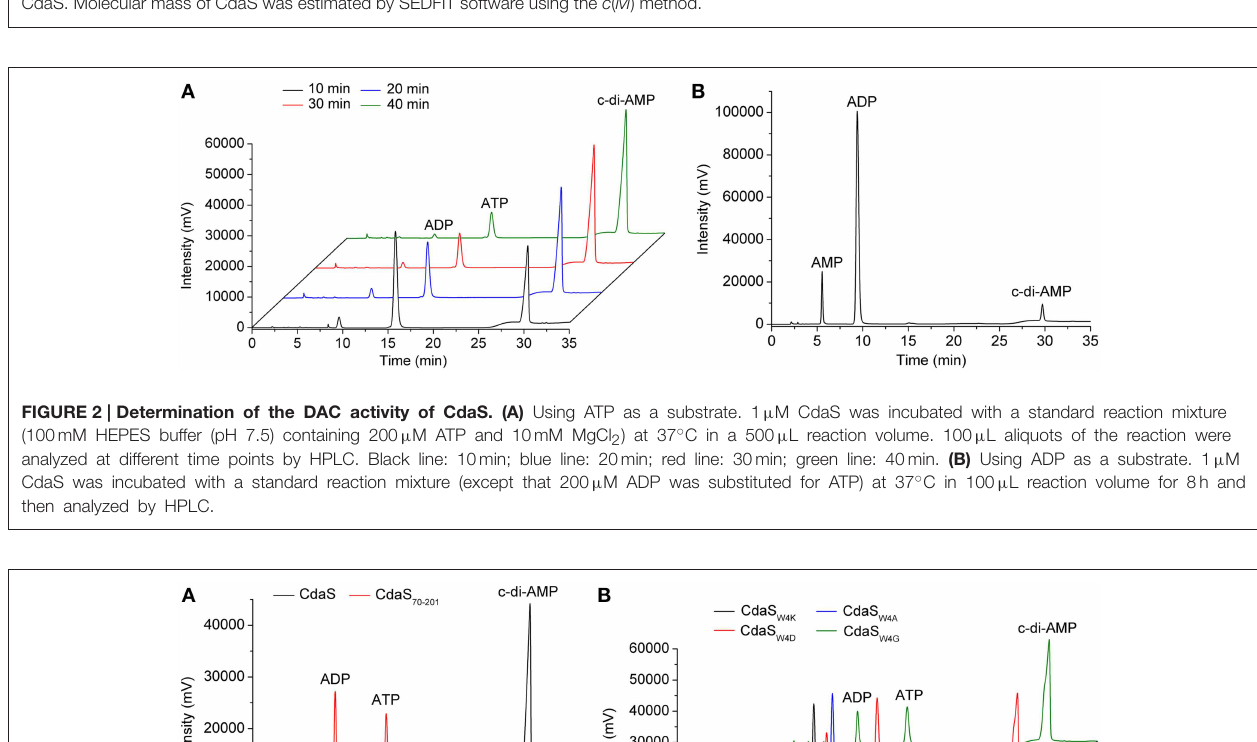
FIGURE 1 | Purification and oligomerization of B. thuringiensis CdaS. (A) 12% SDS-PAGE analysis of purified CdaS. LaneM is the PageRulerTM Prestained Protein Ladder Marker (Thermo Scientific). (B) Superdex 200 Gel filtration chromatography of CdaS. (C) Analytical ultracentrifugation with sedimentation velocity of CdaS. Molecular mass of CdaS was estimated by SEDFIT software using the c ( M ) method.